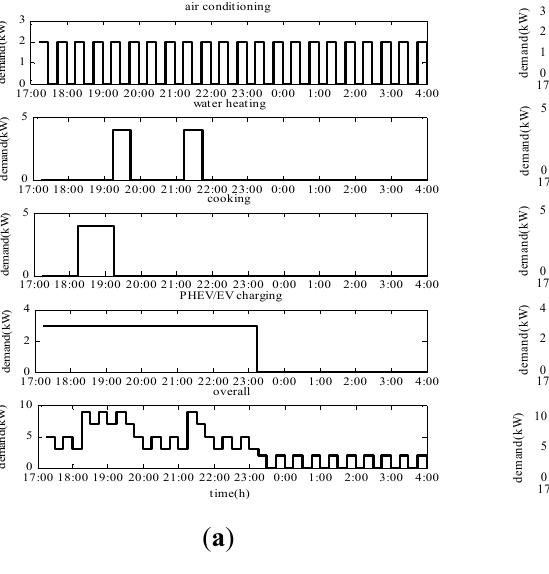
Figure 3. Household energy consumption: ( a ) without rescheduling the charging period and ( b ) with rescheduling the charging